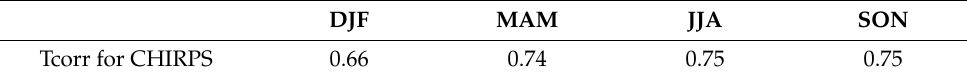
Table 6. Temporal correlation coefficient (Tcorr) for comparison between time series of CWB and CHIRPS in each individual season during 1981–2019. DJF MAM JJA SON Tcorr for CHIRPS